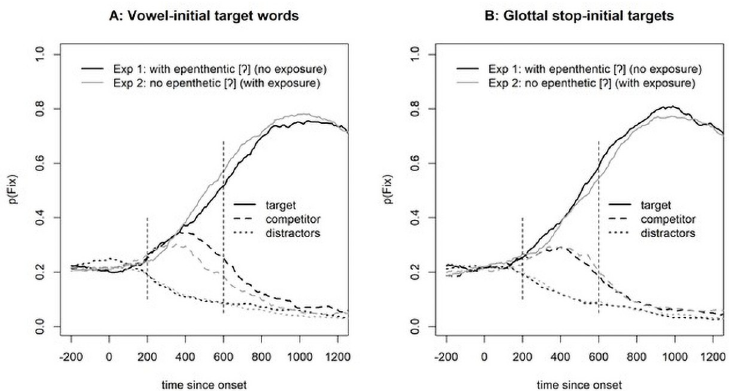
Fig 7. Eye-tracking results from Experiment 2 compared with those from Experiment 1. Note that in Experiment 1, vowel-initial targets were presented with an epenthetic glottal stop, and in Experiment 2, they were presented without such a stop. For glottal stop-initial targets, the signals in the two experiments were identical, but participants might have learned that a glottal stop was unlikely to be epenthetic, which would rule out vowel-initial targets from the onset-